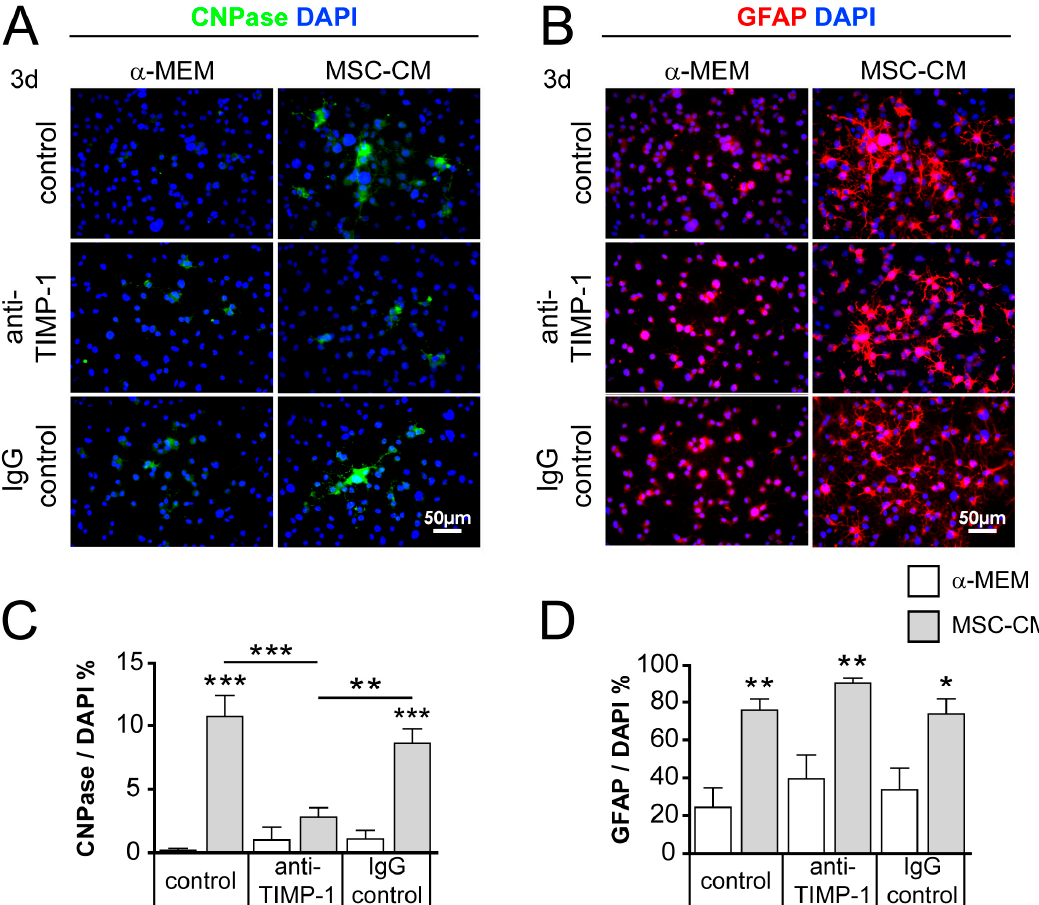
Figure 7. Blocking the tissue inhibitor of metalloproteinase type 1 (TIMP-1) in MSC-CM reduced its pro-oligodendroglial activity on cultured aNSCs. Representative immunocytochemical staining of 2 ′ ,3 ′ -cyclic-nucleotide 3 ′ -phosphodiesterase (CNPase)- ( A ) and GFAP-positive ( B ) cells treated either with control (no antibody), anti-TIMP-1, or immunoglobulin G (IgG) control pre-incubated with α -MEM or MSC-CM after 3 days in culture. ( C ) Quantification of CNPase- and GFAP-positive ( D ) cell numbers. Number of experiments n = 4. Statistical significance was calculated using a two-way ANOVA with Bonferroni posttest: * p ≤ 0.05, ** p ≤ 0.01, *** p ≤ 0.001.